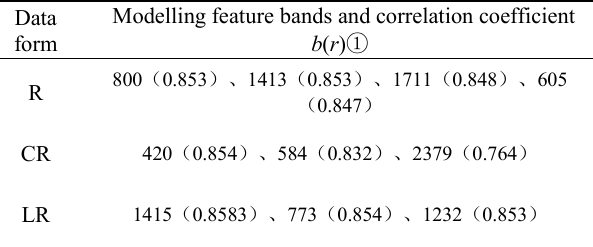
Table3. Participation in modelling characteristic bands and correlation coefficients